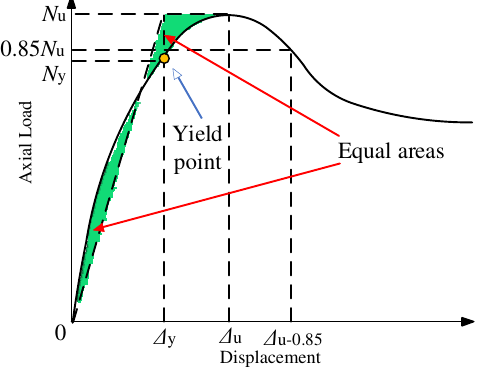
Figure 9. Equivalent elastic-plastic energy method.